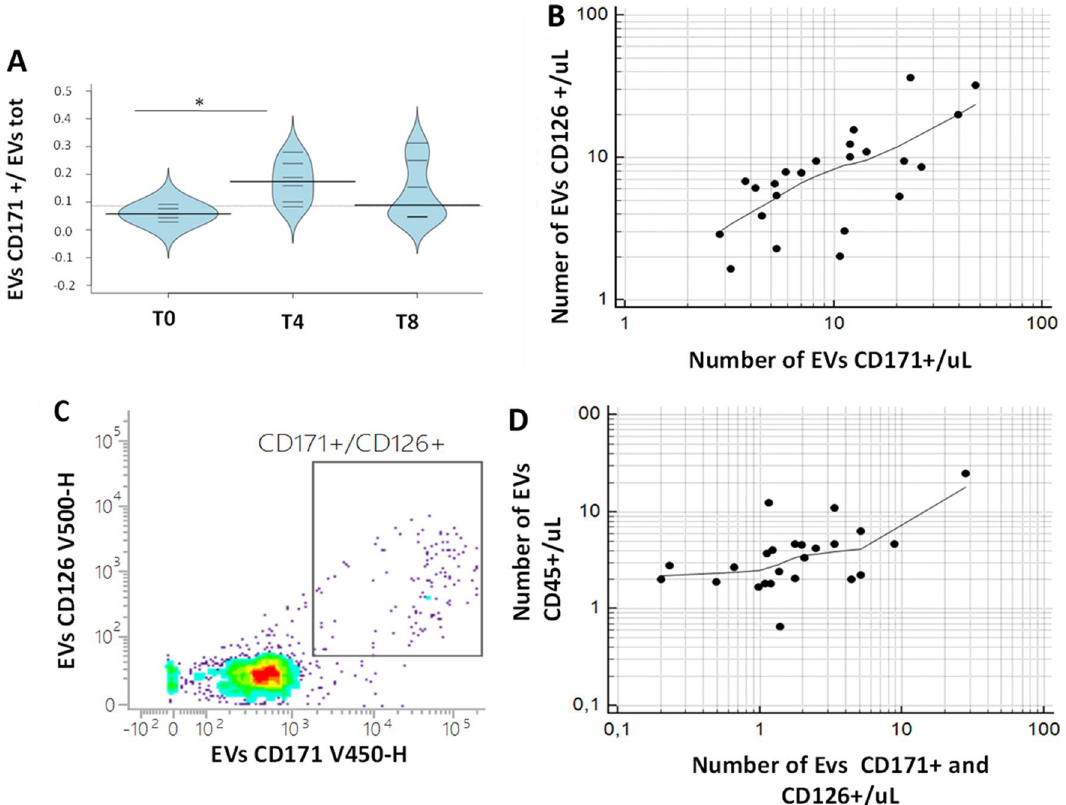
Figure 4. EVs characterization in tears during rhNGF treatment. ( A ) Bean plots reporting the distribution of relative numbers of EVs CD171 + (ratio between EVs CD171+ and total EVs) in the comparison between tear samples collected during rhNGF treatment. The polygon shape (in light blue) represents the density trace of each variable, and inside to that, a scatter plot shows all individual measurements for each single NK patient (black lines). * means p-value < 0.05, at the Student’s t-test and/or Mann Whitney U-test. ( B ) Rank correlation (Spearman’s coefficient of Rank correlation (rho) = 0.71, and p = 0.0001) between the number of EVs CD171+ and EVs 126+ counted and gated in tears samples collected during rhNGF treatment. ( C ) The CD171/CD126 dot-plot shows the gate identifying the CD171+/CD126+ population of EVs. ( D ) Rank correlation (Spearman’s coefficient of Rank correlation (rho) = 0.54, and p = 0.0067) between double positive EVsCD171+/CD126+ with EVs CD45+ in tears samples collected during rhNGF